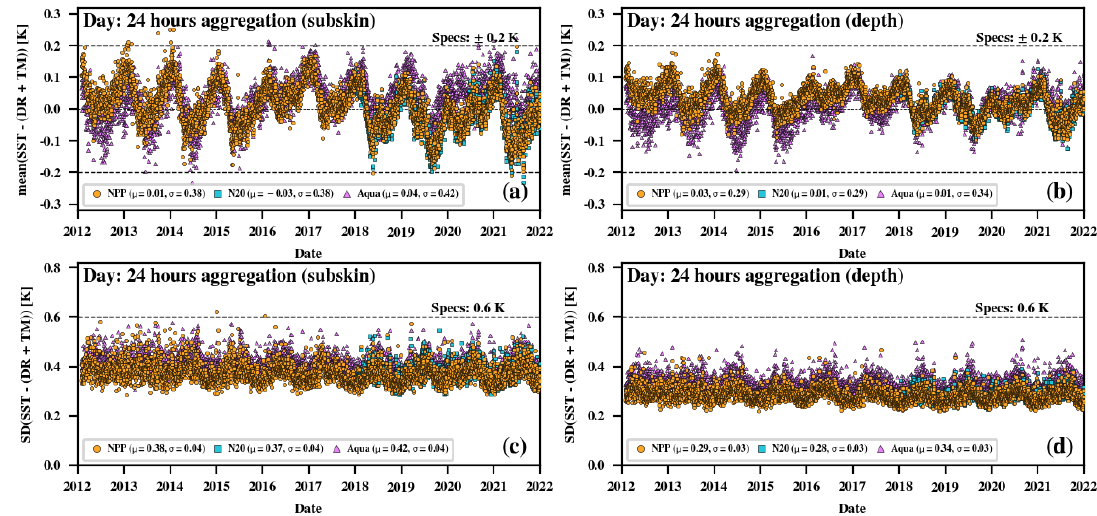
Figure 8. Panels ( a – d ) show the same results as in Figure 7 but for the